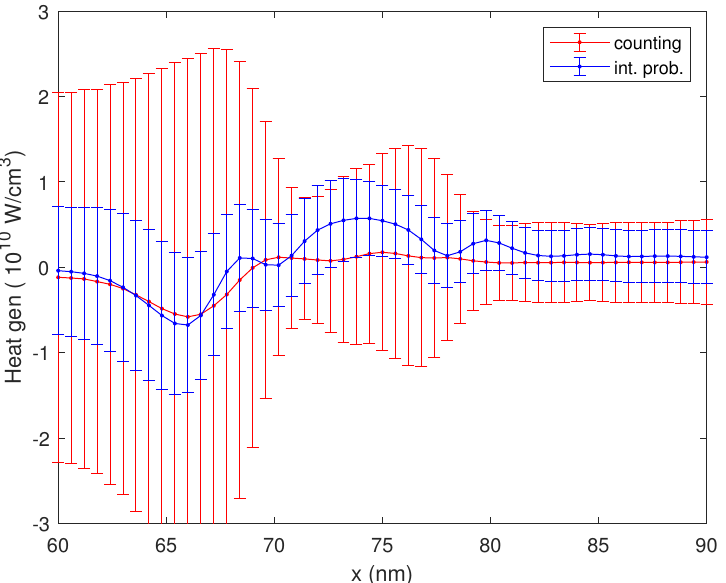
Figure 4. The heat generation rate vs. position for V b = 0.8 V evaluated by means of the counting estimator (30) and the integrated probability estimator (32), with error